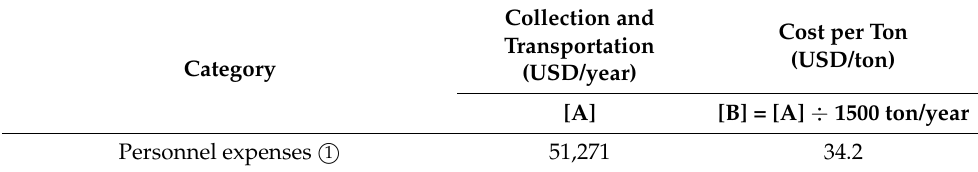
Table 5. Collection and transportation unit price of